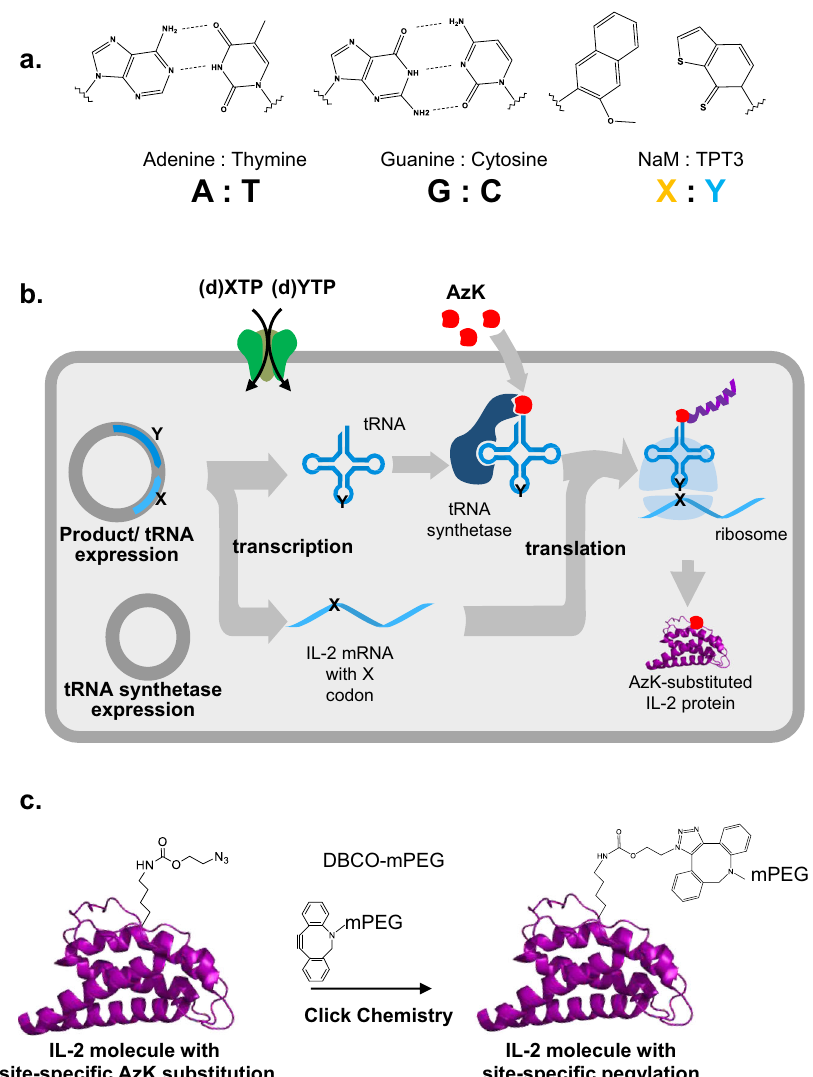
Fig. 1 Overview of the X – Y expanded genetic code technology. a Structures of the natural base pairs A-T (left) and G-C (center) and the X – Y synthetic DNA base pair (right, highlighted in orange/blue). Rather than utilizing hydrogen bond donors and acceptors between pairs (dotted lines), the synthetic base pair formed between NaM (X) and TPT3 (Y) utilizes non-Watson – Crick mode of pairing that is based predominantly on hydrophobic packing interactions. b Schematic of the semi-synthetic organism (SSO) platform based on E. coli BL21(DE3). The organism constitutively expresses a variant of the PtNTT2 nucleotide transporter (green) 11 , which mediates the transport of X and Y nucleoside triphosphates from the growth medium into the cytoplasm for DNA and RNA synthesis. X – Y containing DNA sequences are transcribed into mRNA and tRNA that contain the codon (AXC) and anticodon sequences (GYU), respectively. The orthogonal tRNA synthetase PylRS from M. barkeri (blue) speci fi cally recognizes the AzK (red shape) provided in the culture medium and charges this residue onto the corresponding GYU anticodon-containing orthogonal pylT tRNA. Finally, the cell ’ s ribosomal translation machinery utilizes the resulting pools of AzK-charged tRNA (GYU) to speci fi cally decode the AXC codon, allowing the production of site-speci fi cally AzK- modi fi ed protein product (purple chain with red shape) in concert with the native translational machinery. c Schematic showing an example AzK- IL-2 precursor molecule (purple chain with AzK incorporated). Reaction of the AzK-containing IL-2 proteins with DBCO-mPEG generates the site-speci fi c and covalent attachment of the mPEG moiety to the AzK (one regioisomeric species shown). An array of different IL-2 variants with AzK incorporated into distinct sites was created and the scheme shown was employed to pegylate each